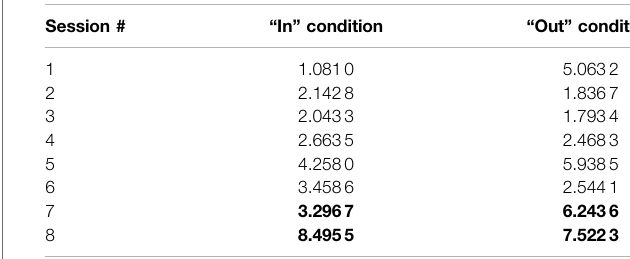
TABLE 3 | Accumulated rewards for the Dash robot. The “ in ” condition corresponds to the infant wearing the full-body-weight support mechanism (see Figure 6 ) and the “ out ” condition represents completely unassisted infant motion. The last two highlighted rows give outcomes on the reward obtained